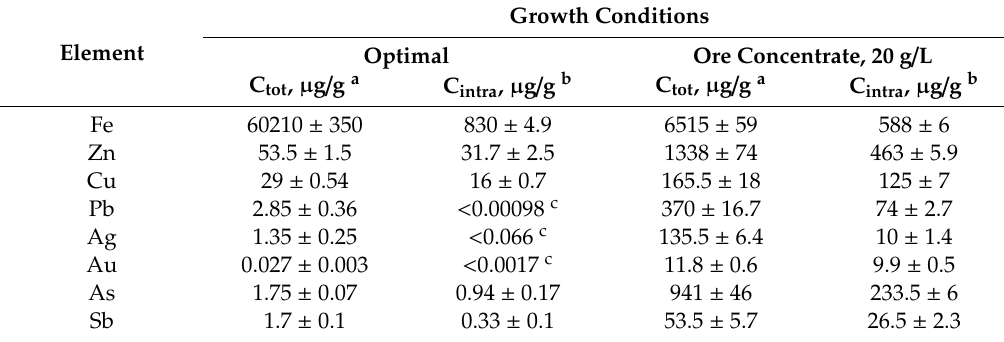
Table 2. Total cellular accumulation and intracellular concentrations of metal(loid)s at the late- exponential phase of Sb. thermotolerans